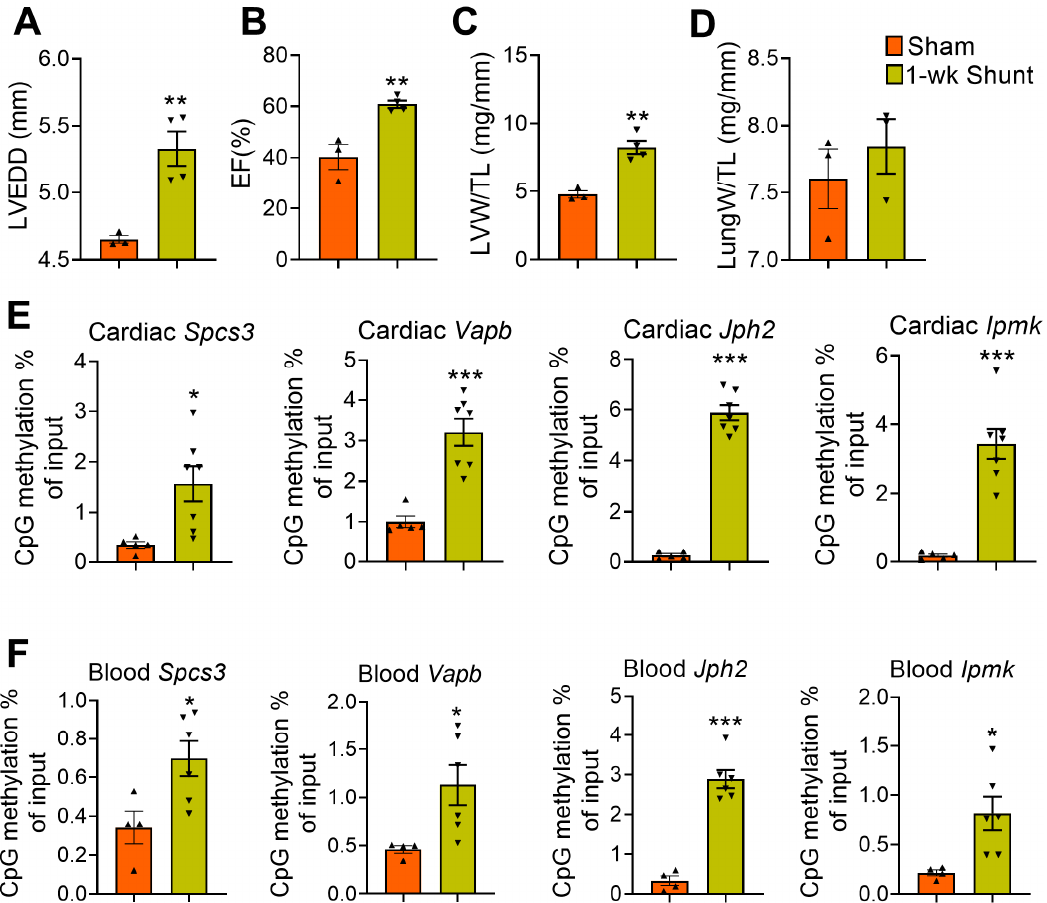
Figure 6. Promoter DNA methylation assessment in the hearts and blood isolated from short-term VO-exposed mice (1 week post-shunt). ( A – D ) Echocardiographic and morphometric parameters: LVEDD, LV end-diastolic diameter ( A ); EF, ejection fraction ( B ); LVW/TL, LV weight-to-tibia length ( C ); LungW/TL, lung weight-to-tibia length ( D ). ( E , F ) MeDIP-qPCR to assess DNA methylation in the hearts ( E ) and blood ( F ). Values are mean ± SEM, n = 3–7 mice/group. * p < 0.05, ** p < 0.01, *** p < 0.001 vs. sham, two-tailed unpaired Student’s t -test.